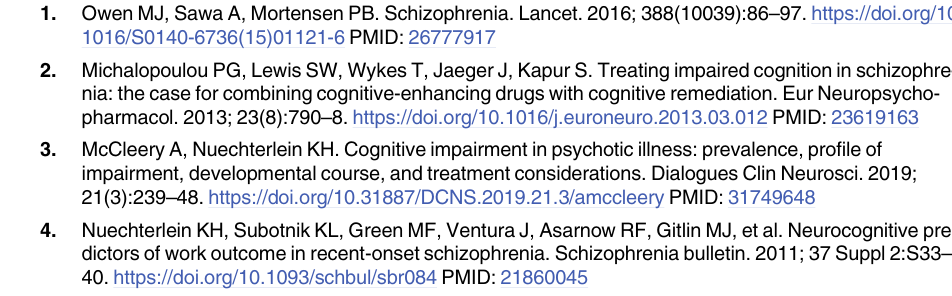
S1 Table. Standardized data of neuropsychological performances measures. Standardized data (t-scores and z-scores) of neuropsychological performance measures separated by time of measurement and group. Note, lower t-scores indicate better performance except for problem solving where higher values indicate better performance. For d -prime and the response criteria C z-scores are presented where higher d -prime values indicate better performance and higher C values indicate a more conservative response